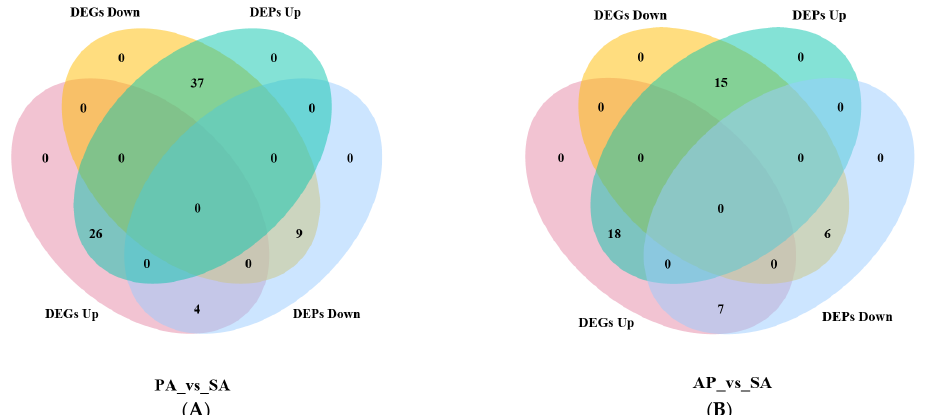
Figure 5. Venn diagrams of the differentially expressed genes (DEGs) and differentially expressed proteins (DEPs) of all samples. ( A ) Venn diagrams of DEGs and DEPs common to peach/apricot (PA); ( B ) Venn diagrams of DEGs and DEPs common to apricot/peach